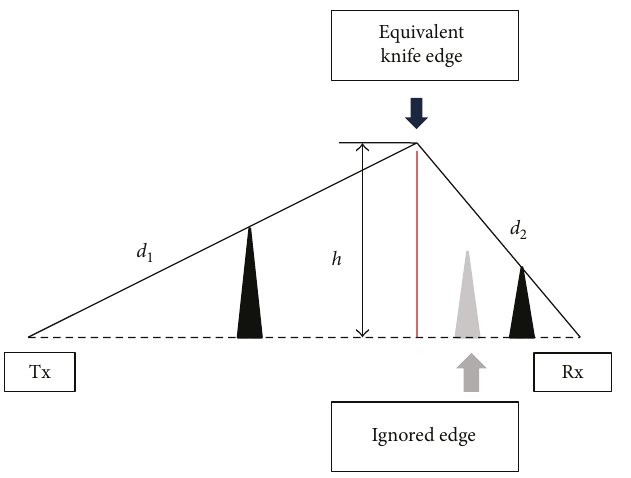
Figure 1: Concept of Bullington method.